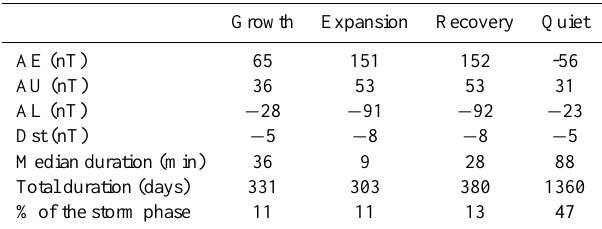
Table 6. Median values of substorm phases during non-storm times.